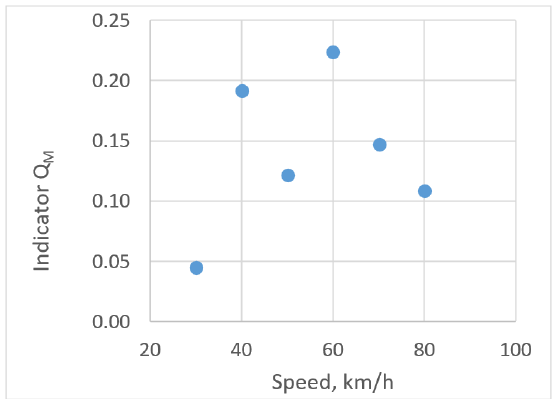
Figure 12. Values of Q M , considering the maximal forces of loaded wagon.